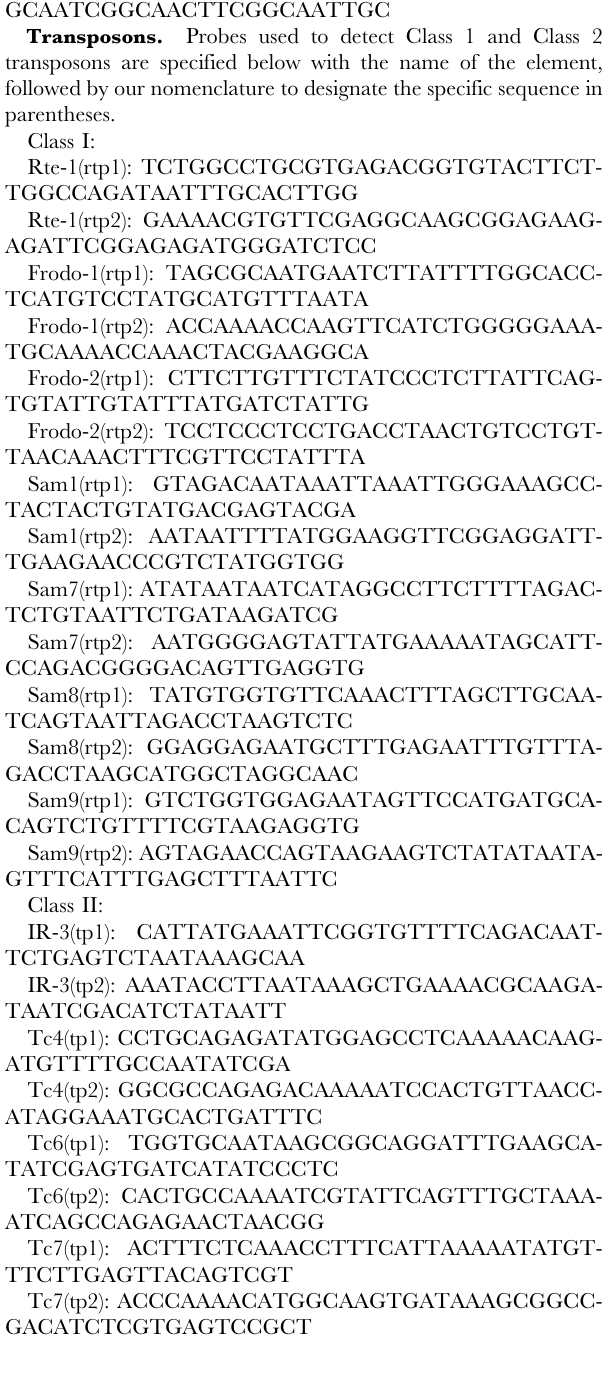
Figure S2 Small DNA pieces are detected with sense or